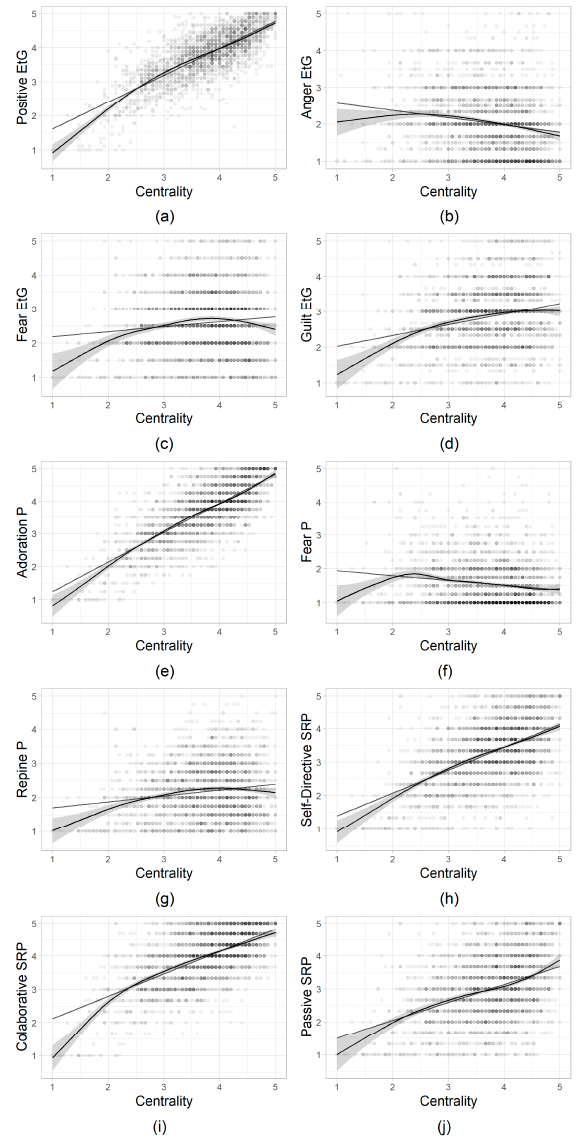
Figure 1. Relationships between centrality of religiosity scale (CRS) and religious structure test (RST) subscales included in the study ( n = 2331). Gray lines describe linear models, black lines indicate semiparametric models using splines, and the gray area is 95% confidence interval (CI) for the splines. The panels show the following regressions on CRS: ( a ) positive emotions toward God; ( b ) anger toward God; ( c ) fear toward God; ( d ) guilt toward God; ( e ) adoration prayer; ( f ) fear prayer; ( g ) repine prayer; ( h ) self-directive style of request prayer; ( i ) collaborative style of request prayer; and ( j ) passive style of request prayer.